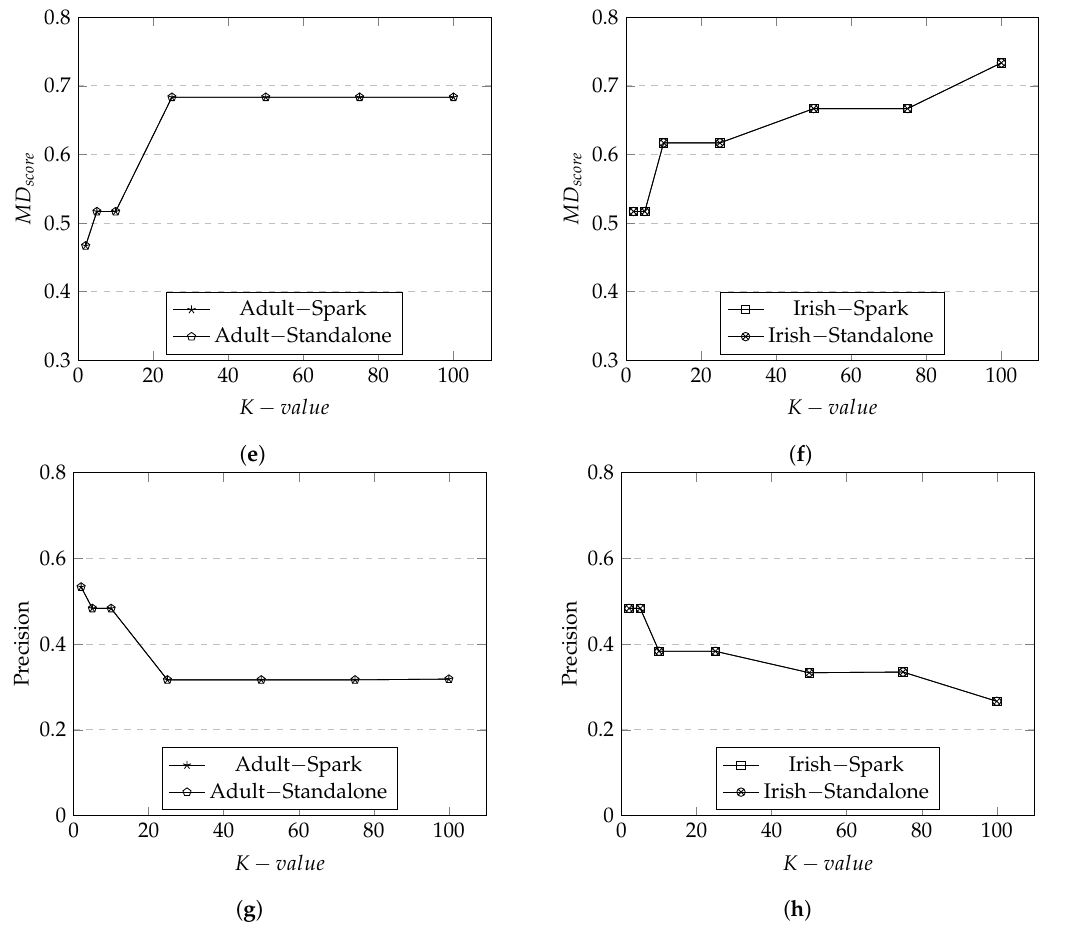
Figure 8. Data Utility Metrics for Adult and Irish datasets on both Spark and Standalone. ( a ) Discernibility Metric in Adult Dataset; ( b ) Discernibility Metric in Irish Dataset; ( c ) Average Equivalence Class in Adult Dataset; ( d ) Average Equivalence Class in Irish Dataset; ( e ) Minimal Distortion in Adult Dataset; ( f ) Minimal Distortion in Irish Dataset; ( g ) Precision Metric in Adult Dataset; ( h ) Precision Metric in Irish Dataset.